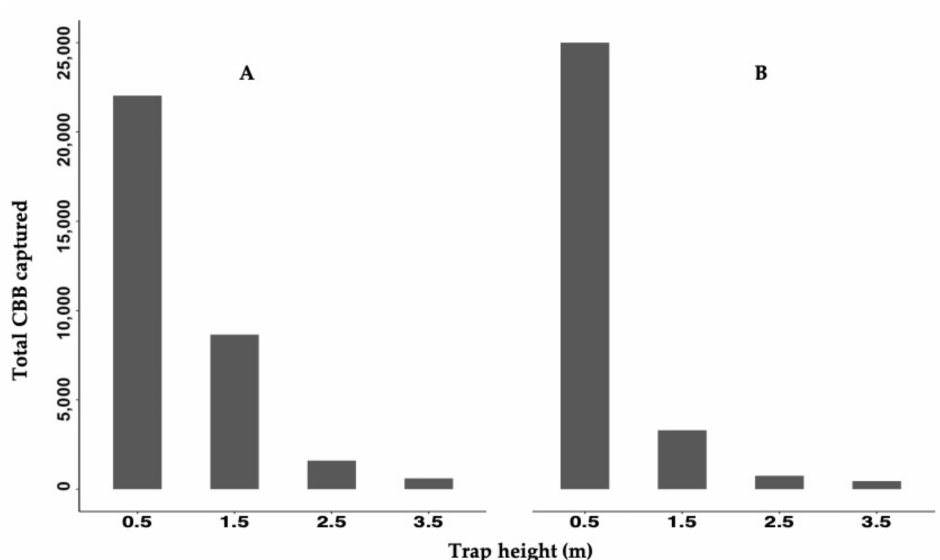
Figure 2. The total CBB captured at each height in each experiment. Experiment A was established from 2 March to 4 September 2019 and Experiment B from 2 October to 4 March 2020 in Adjuntas, Puerto